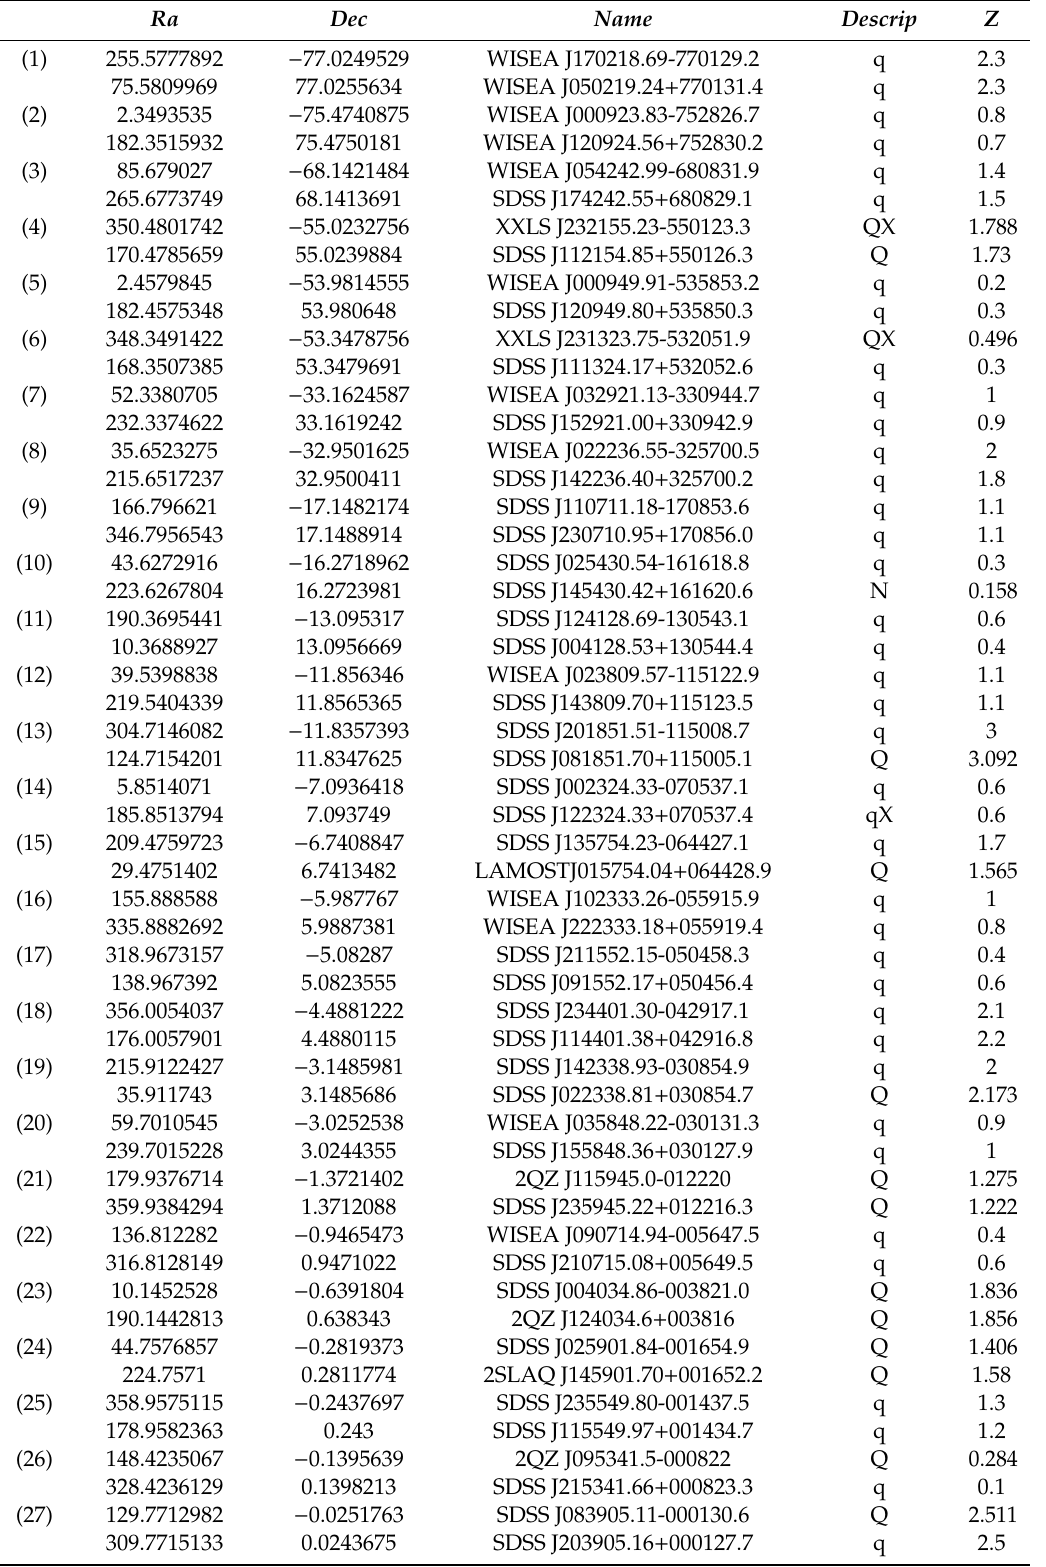
Table A14. Pairs of opposite quasars from the Milliquas 6.3 catalog for the cosmic mirror e ff ect. Accuracy is of 0.001 ◦ for ra and dec and 0.2 for redshift z . Descrip column is the classification of object, see